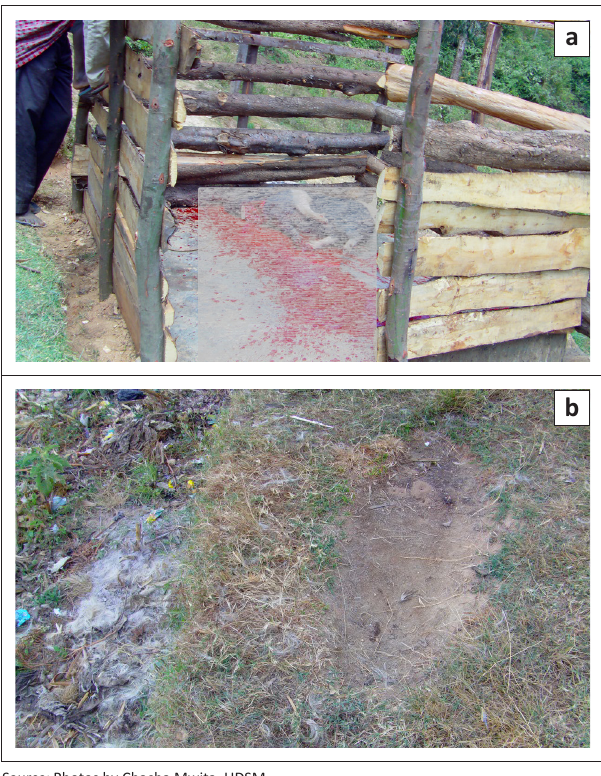
FIGURE 2: The Mbulu District, (a) an individually owned slaughtering pen at a pork seller’s house and (b) a slaughtering place near a local brew